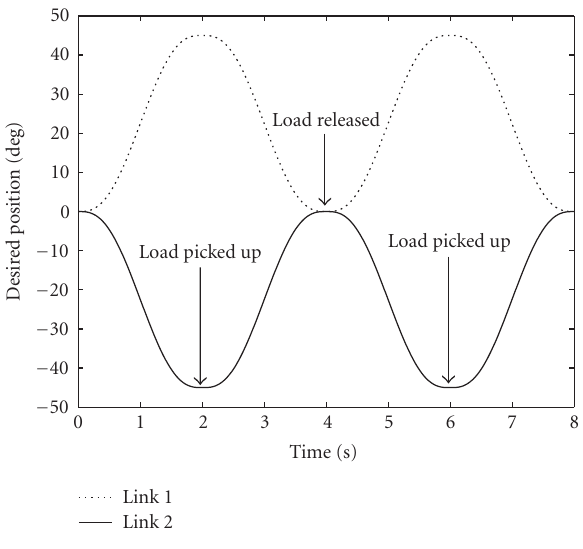
Figure 7: Desired trajectory